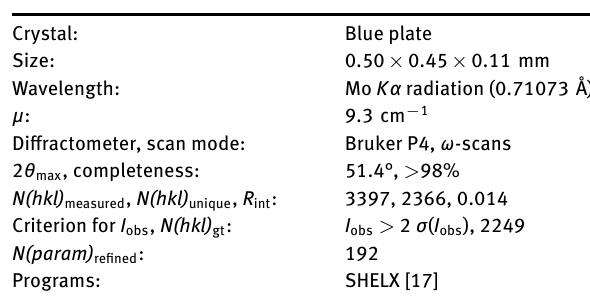
Table 1: Data collection and